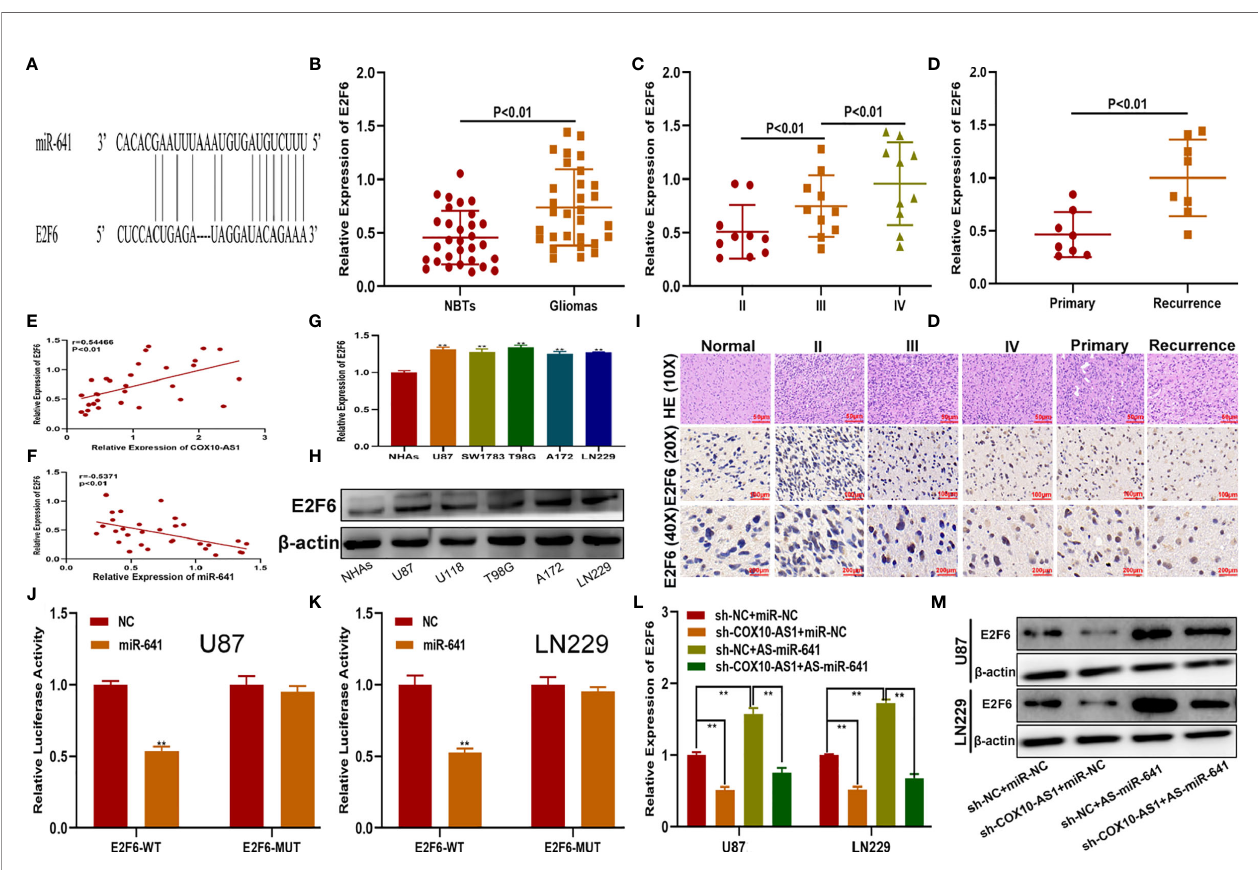
FIGURE 6 | E2F6 is the functional target of the COX10-AS1/miR-641 axis. (A) The putative binding sites of miR-641 on E2F6 were predicted by an online database. (B) The relative expression of E2F6 in clinical specimen. (C) The relative expression of E2F6 in different grade of glioma. (D) The relative expression of E2F6 in primary and recurrent glioma. (E) Pearson ’ s correlation analysis of COX10-AS1 expression and E2F6 expression in clinical specimens. (F) Pearson ’ s correlation analysis of miR-641 expression and E2F6 expression in clinical specimens. (G, H) The relative expression of E2F6 in NHAs and glioma cell lines measured by qRT- PCR and western blot. (I) The expression level of E2F6 in different grades of glioma detected by immunohistochemistry. (J, K) Luciferase reporter assay indicated that miR-641 reduced the luciferase activity of E2F6-WT but not E2F6-MUT. (L, M) The relative expression of E2F6 in U87 and LN229 cells transfected with sh-COX10-AS1, miR-641 inhibitor or sh-COX10-AS1 together with miR-641 inhibitor, as measured by qRT-PCR and western blot. **P <